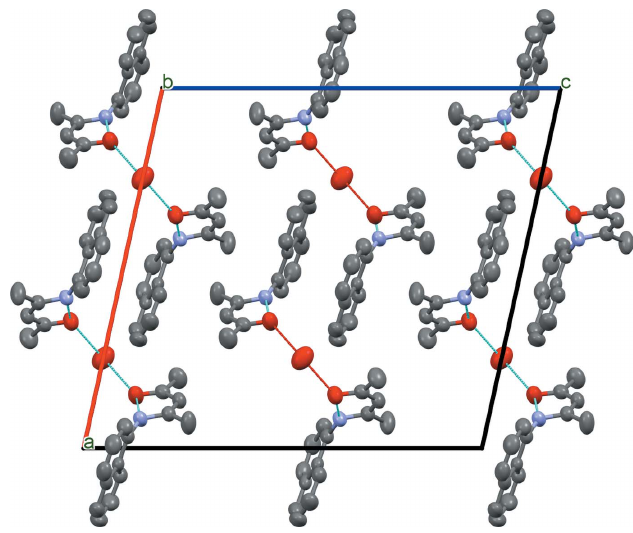
Figure 2 Crystal packing of the title compound viewed down the b axis. O—H (cid:2)(cid:2)(cid:2) O hydrogen bonds are shown as light-green dashed lines. H atoms are omitted.